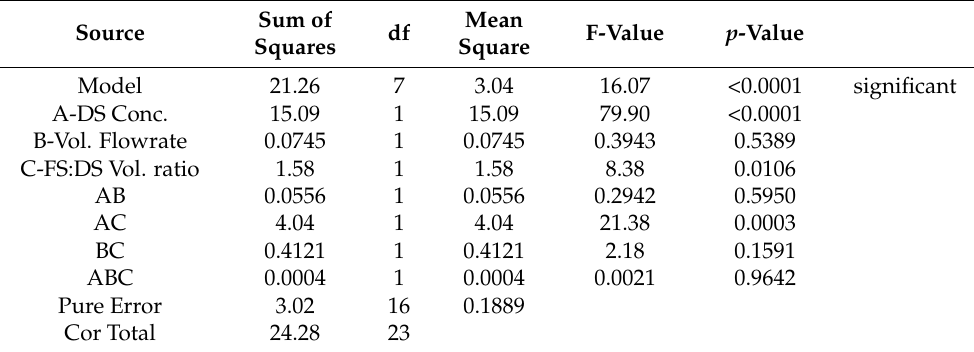
Table 6. ANOVA for J S : effect of DS concentration (A), DS volumetric flowrate (B), and FS:DS volume ratio